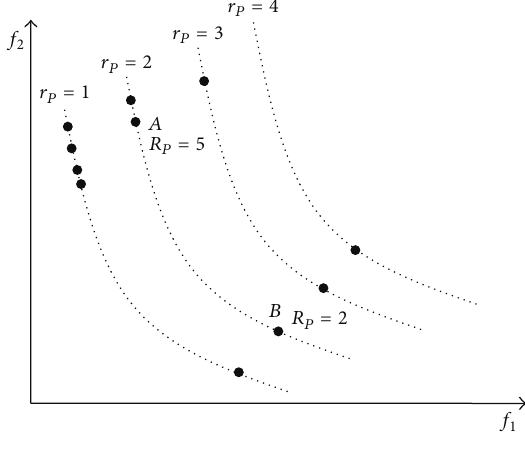
Figure 2: Individual rank